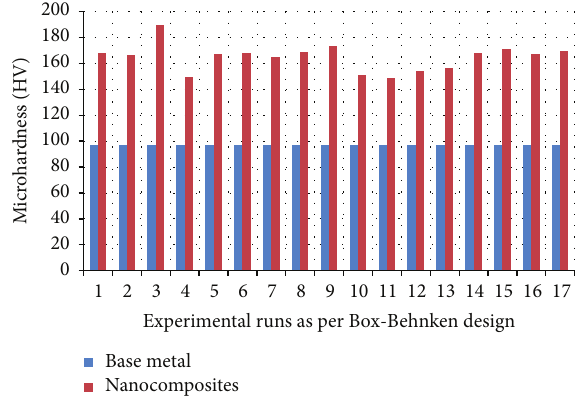
Figure9:Microhardnessofbasemetalandfabricatednanocompos-